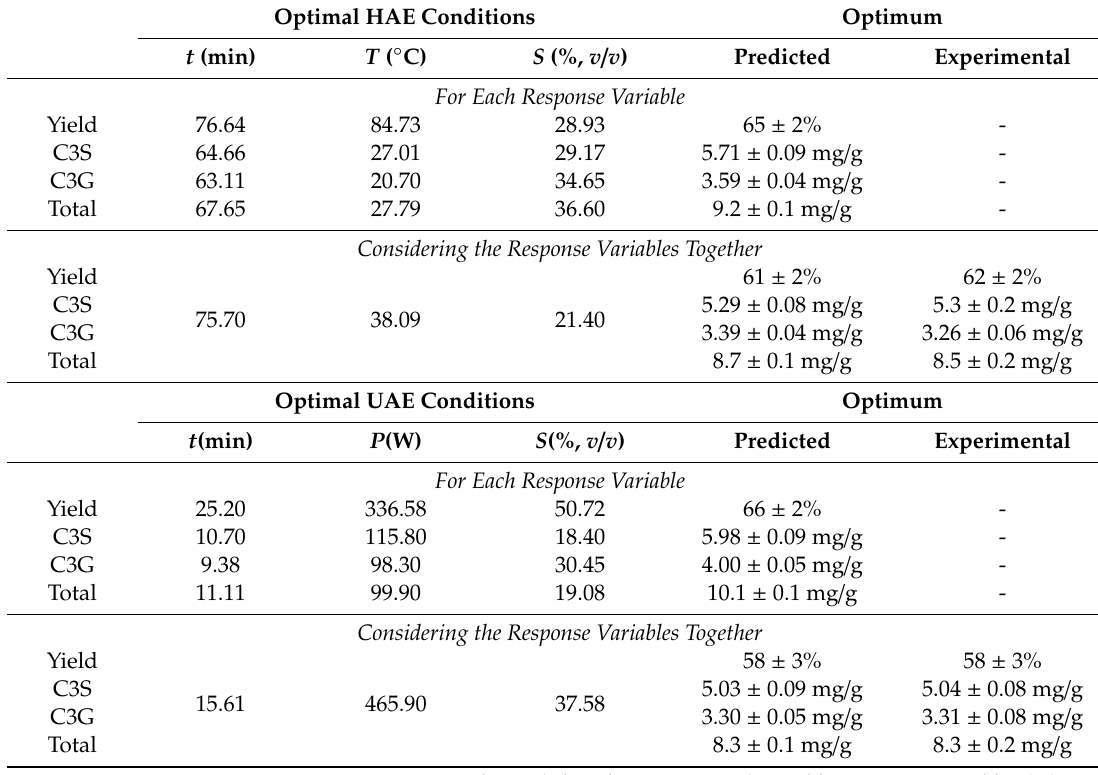
Table 3. Optimal processing conditions that maximize the HAE and UAE extraction of anthocyanins from red raspberry and predicted and experimental